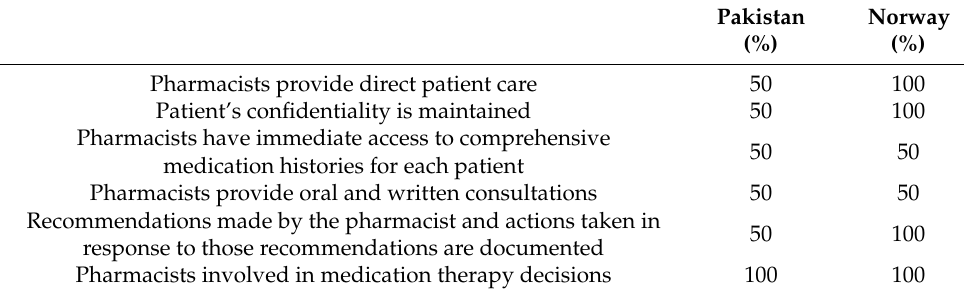
Table 5. Pharmacists’ assessments on optimizing medication therapy.